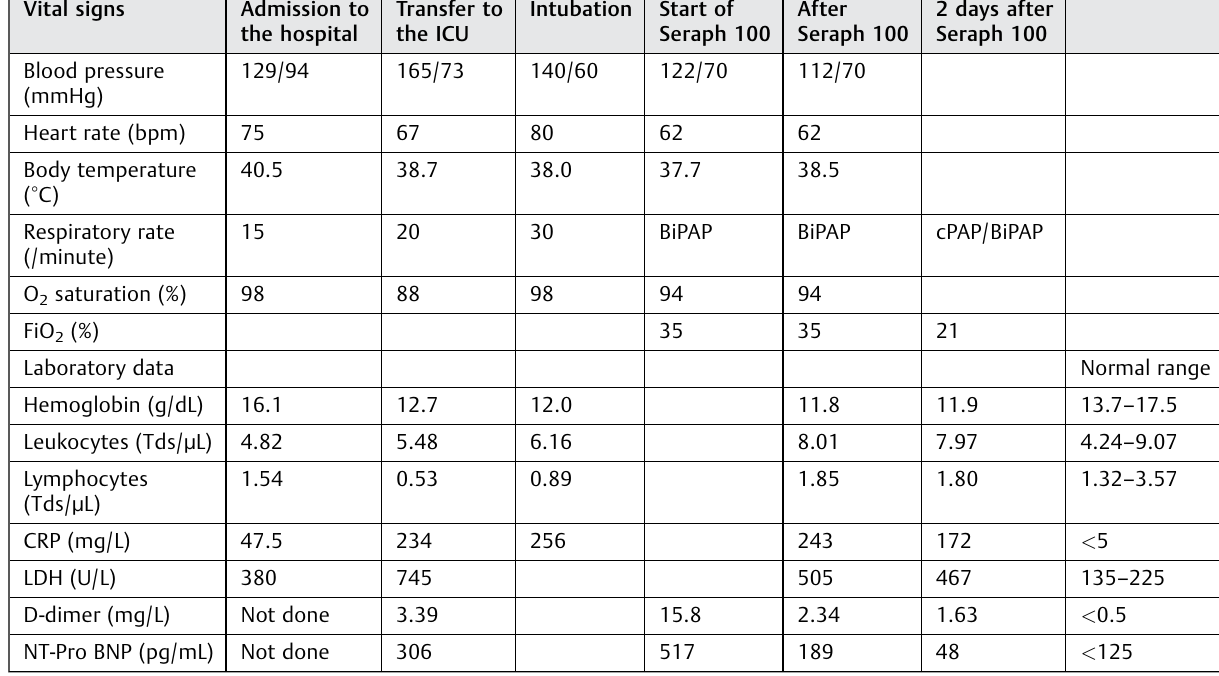
Table 1 Course of Vital signs and laboratory data Vital